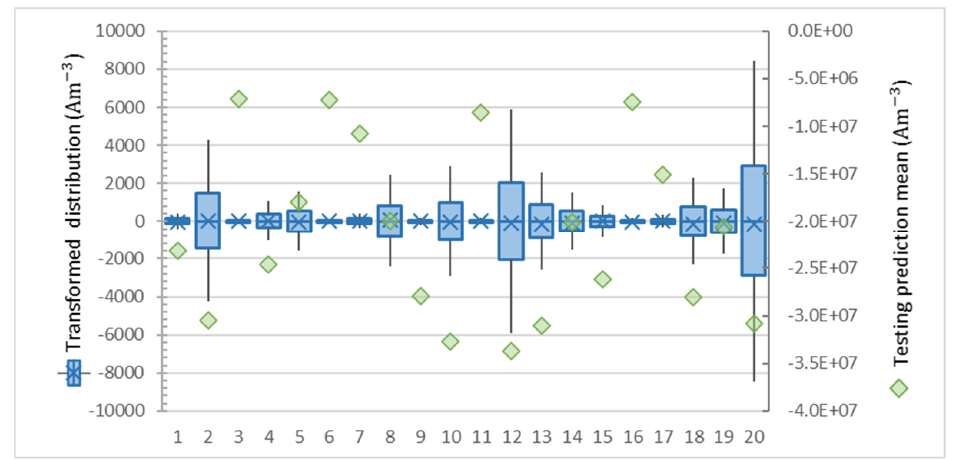
Figure 4. The box plot shows the distribution of the transformed prediction for electrical current source . The bars at the center of the boxes are the means of distribution. The “X” mark on each column indicates the value of the difference between the testing target and the testing prediction mean. The closer the “X” mark is to the center of the column, the better that prediction performance. The scatter plot denotes the testing prediction mean for electrical current source . The predictions for electrical current source are reliable given that prediction means are in the order of 10 7 while the transformed prediction distributions are in the order of 10 3 .